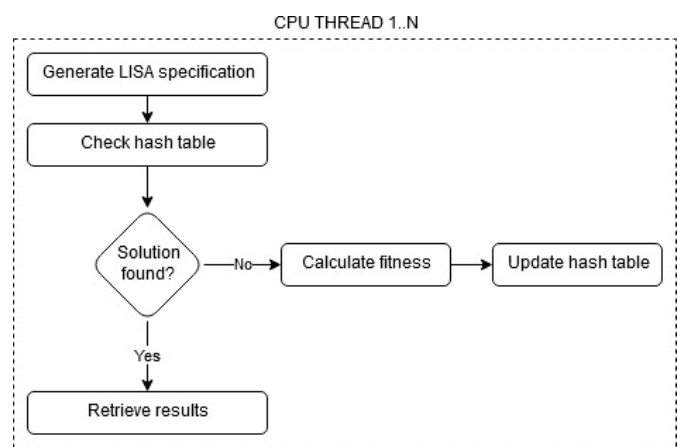
Figure 4. Multi-threaded fitness